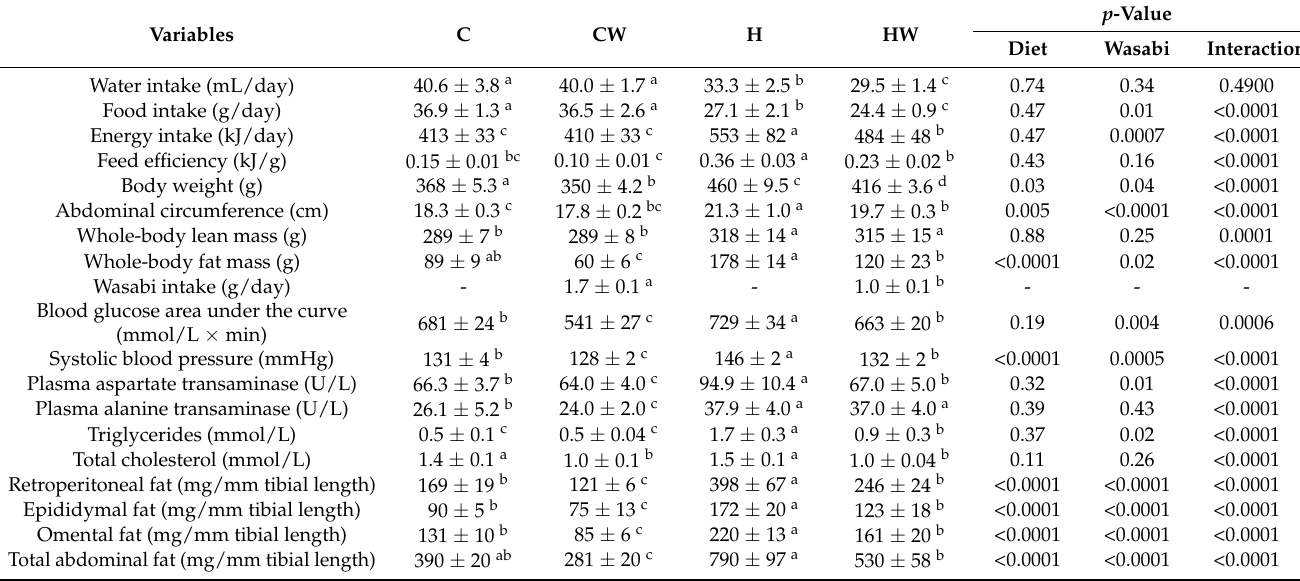
Table 2. Effects of wasabi on physiological and metabolic